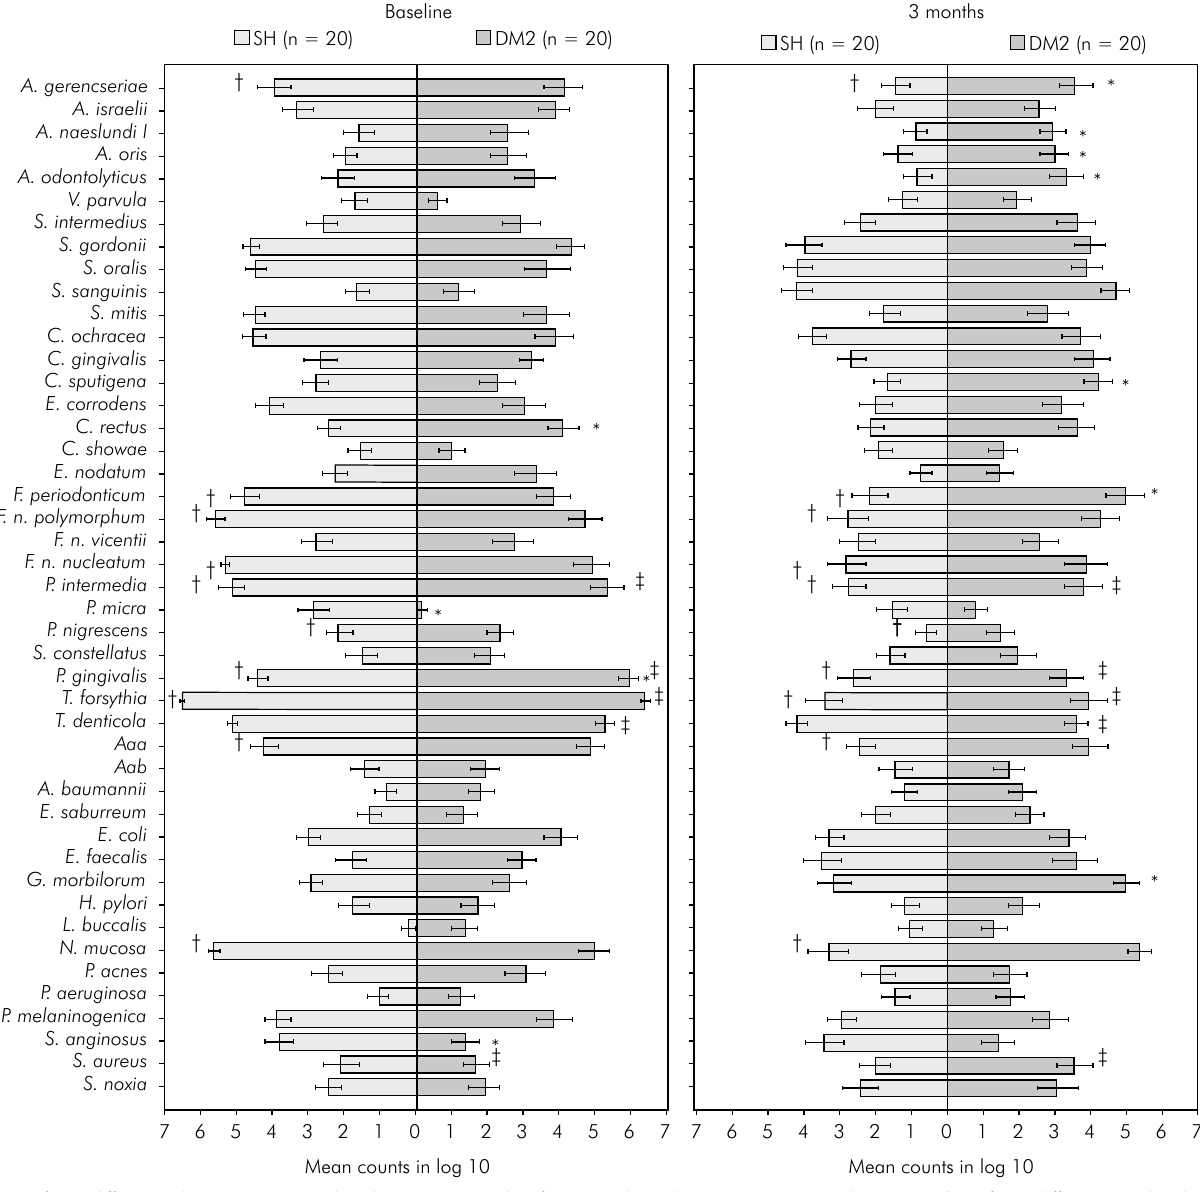
*Significant differences between groups at baseline or at 3 months after SRP (adjusted p ≤ 0.001, Mann-Whitney test). † Significant differences within the SH group over time (adjusted p ≤ 0.001, Wilcoxon test). ‡ Significant differences within the DM2 group over time (adjusted p ≤ 0.001, Wilcoxon test). Figure 2. Mean counts (in log10 ± SEM) of subgingival species evaluated in biofilm samples from individuals with type 2 diabetes (DM2) and systemically healthy (SH) individuals with chronic periodontitis at baseline (left panel) and 3 months (right panel) after SRP. Aa: Aggregatibacter